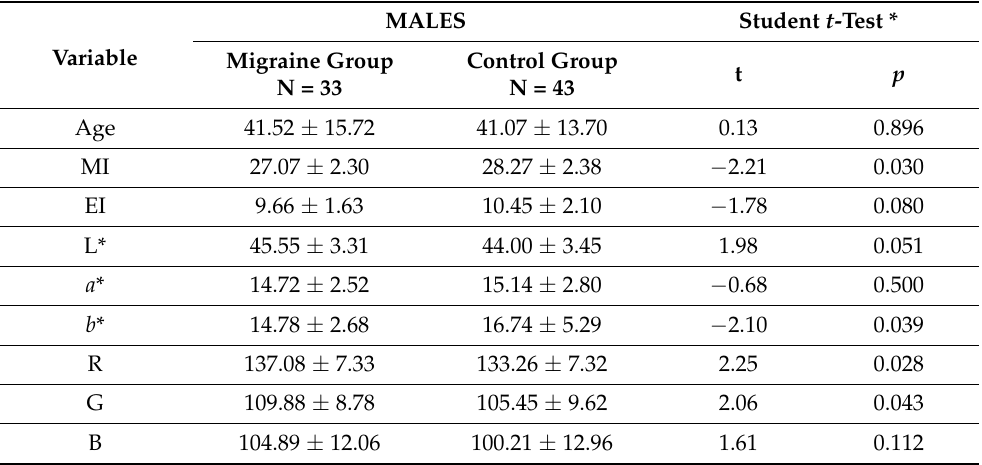
Table 2. Statistical characteristics ( in